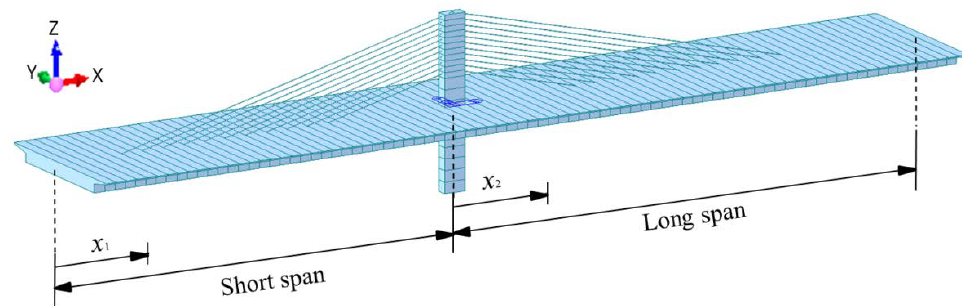
Figure 4. Finite element model of the structure.